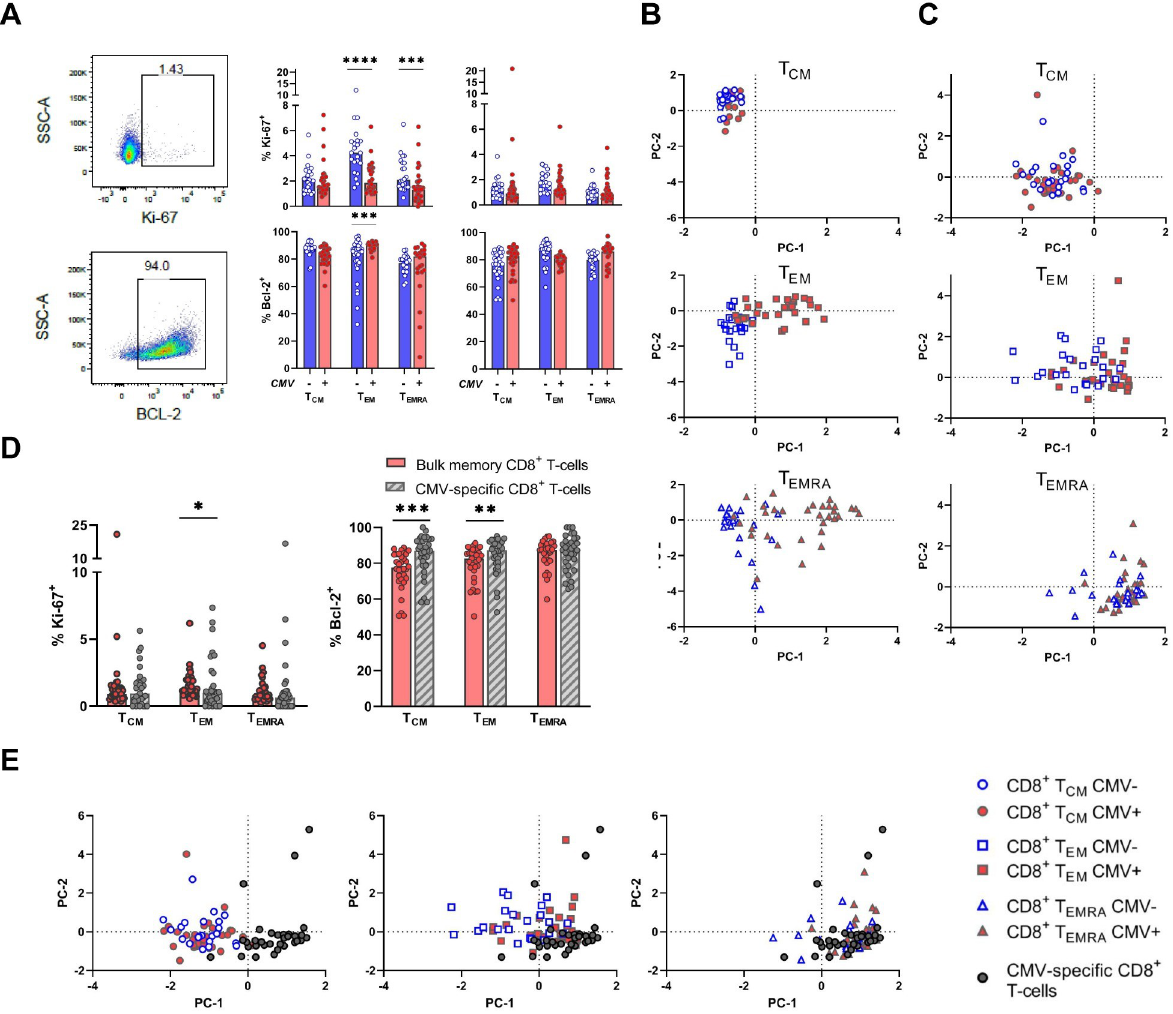
Fig 2. Altered expression of lifespan-associated markers by CD4 + T EM/EMRA cells in CMV infection. (A) Representative flow cytometric plots for gating of Ki-67 and Bcl-2 expression. Graphs represent percentage of positive cells for Ki-67 and Bcl-2 in CMV- and CMV+ individuals by CD4 + and CD8 + T-cells, measured per memory subpopulation. (B) and (C) Principal component analysis (PCA) of CD4 + (B) and CD8 + (C) T-cells based on lifespan-associated markers KLRG-1, CD57, CD28, Ki-67, and Bcl-2 per memory subpopulation. Blue dots represent CMV- individuals, red dots represent CMV+ individuals. (D) Comparison of expression of Ki-67 and Bcl-2 by the total memory CD8 + T-cell pool of CMV+ individuals and by CMV-specific CD8 + T-cells, measured per memory subpopulation. (E) PC analysis of CD8 + T-cells based on lifespan-associated markers KLRG-1, CD57, CD28, Ki-67 and Bcl-2 per memory subpopulation. Bars in (A) and (D) represent medians. Differences between CMV- and CMV + individuals were tested by Mann-Whitney U test. Stars indicate significant differences as follows: � P -value < 0.05, �� P -value < 0.01, ��� P -value < 0.001, ��� P -value <